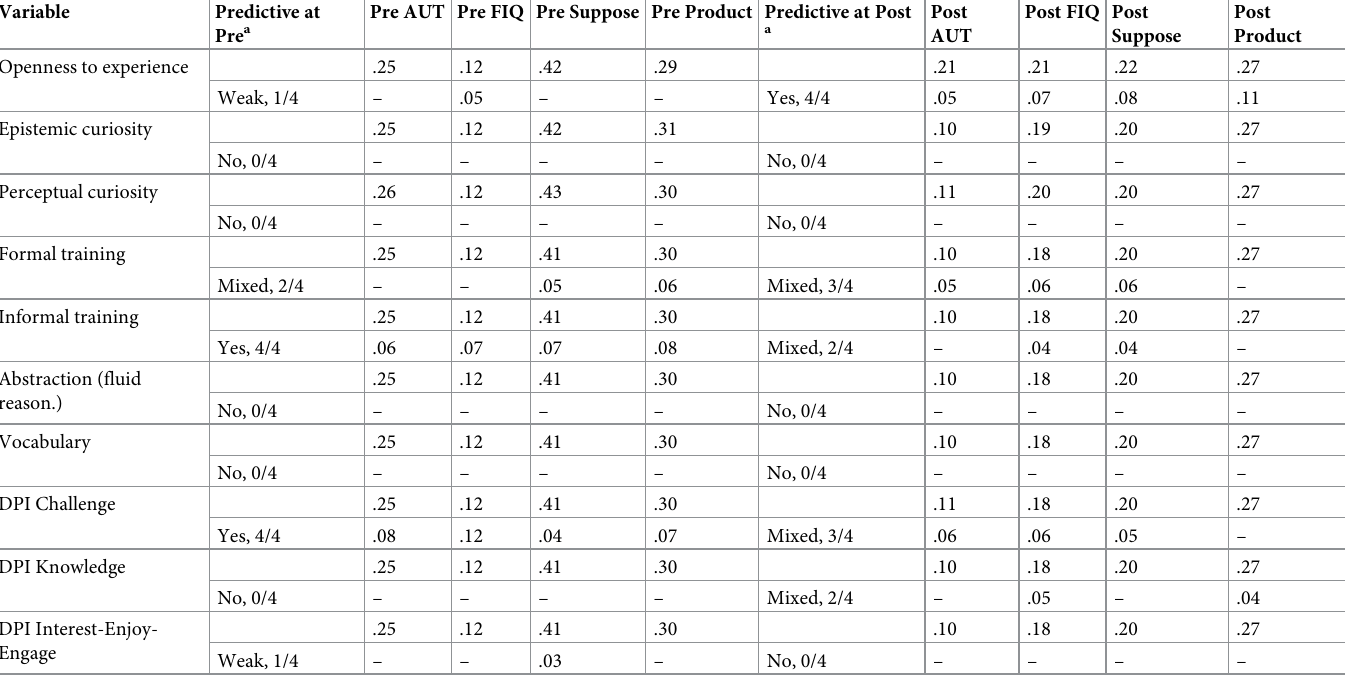
Table 8. Incremental predictive value (change in R 2 ) for originality of Design Product Ideation.